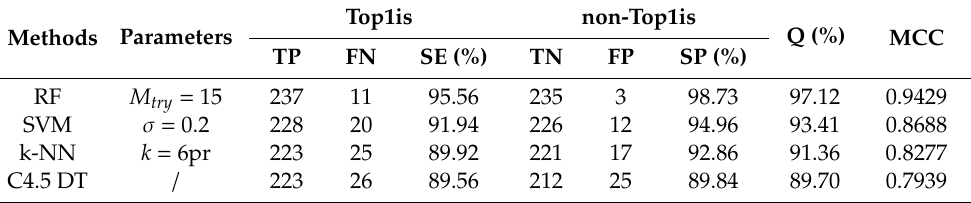
Table 2. The comparison on the prediction accuracies of Top1 inhibitors (Top1is) and Top1 non-inhibitors (non-Top1is) from models random forest (RF), support vector machine (SVM), k-nearest neighbor (k-NN) and C4.5 decision tree (DT) by using the same testing set. Methods